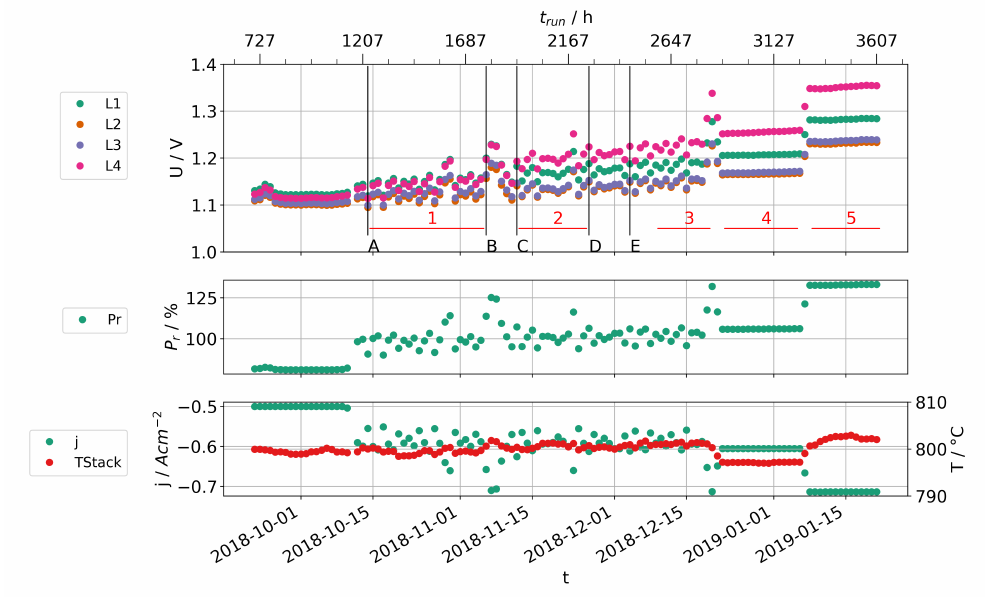
Figure 3. Daily averaged layer voltages (top), relative power (center), current density, and stack temperature (bottom) for stack A. Specific events are marked with capital letters, and operational phases with red numbers.